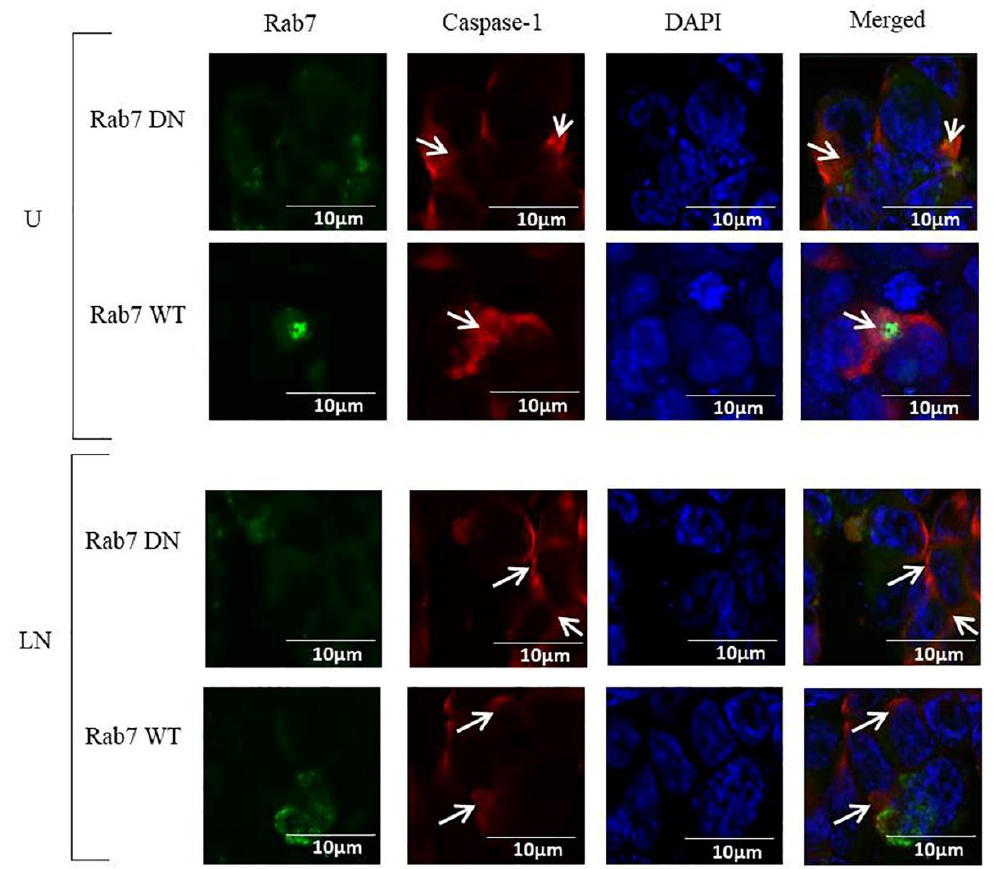
Figure 5. The effects of the transfection of Rab7 DN and Rab7 WT plasmids on the localization of